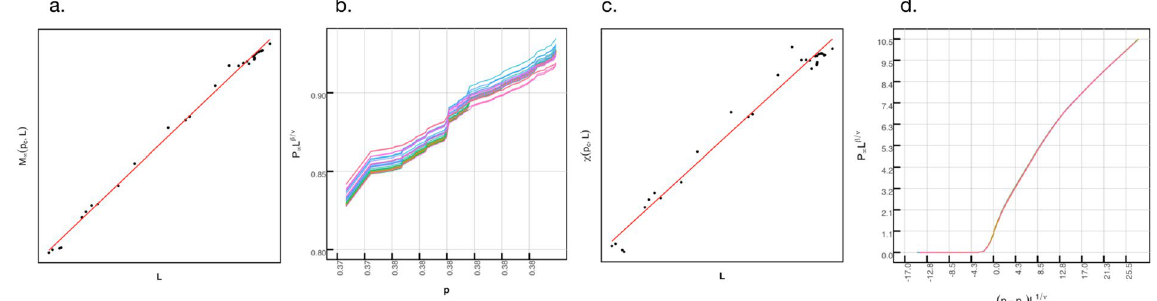
Figure 6. Calculations correcting for the finite size effect (infinite theoretical system), from left to right, ( a ) calculation of D , ( b ) correction of β to calculate ν